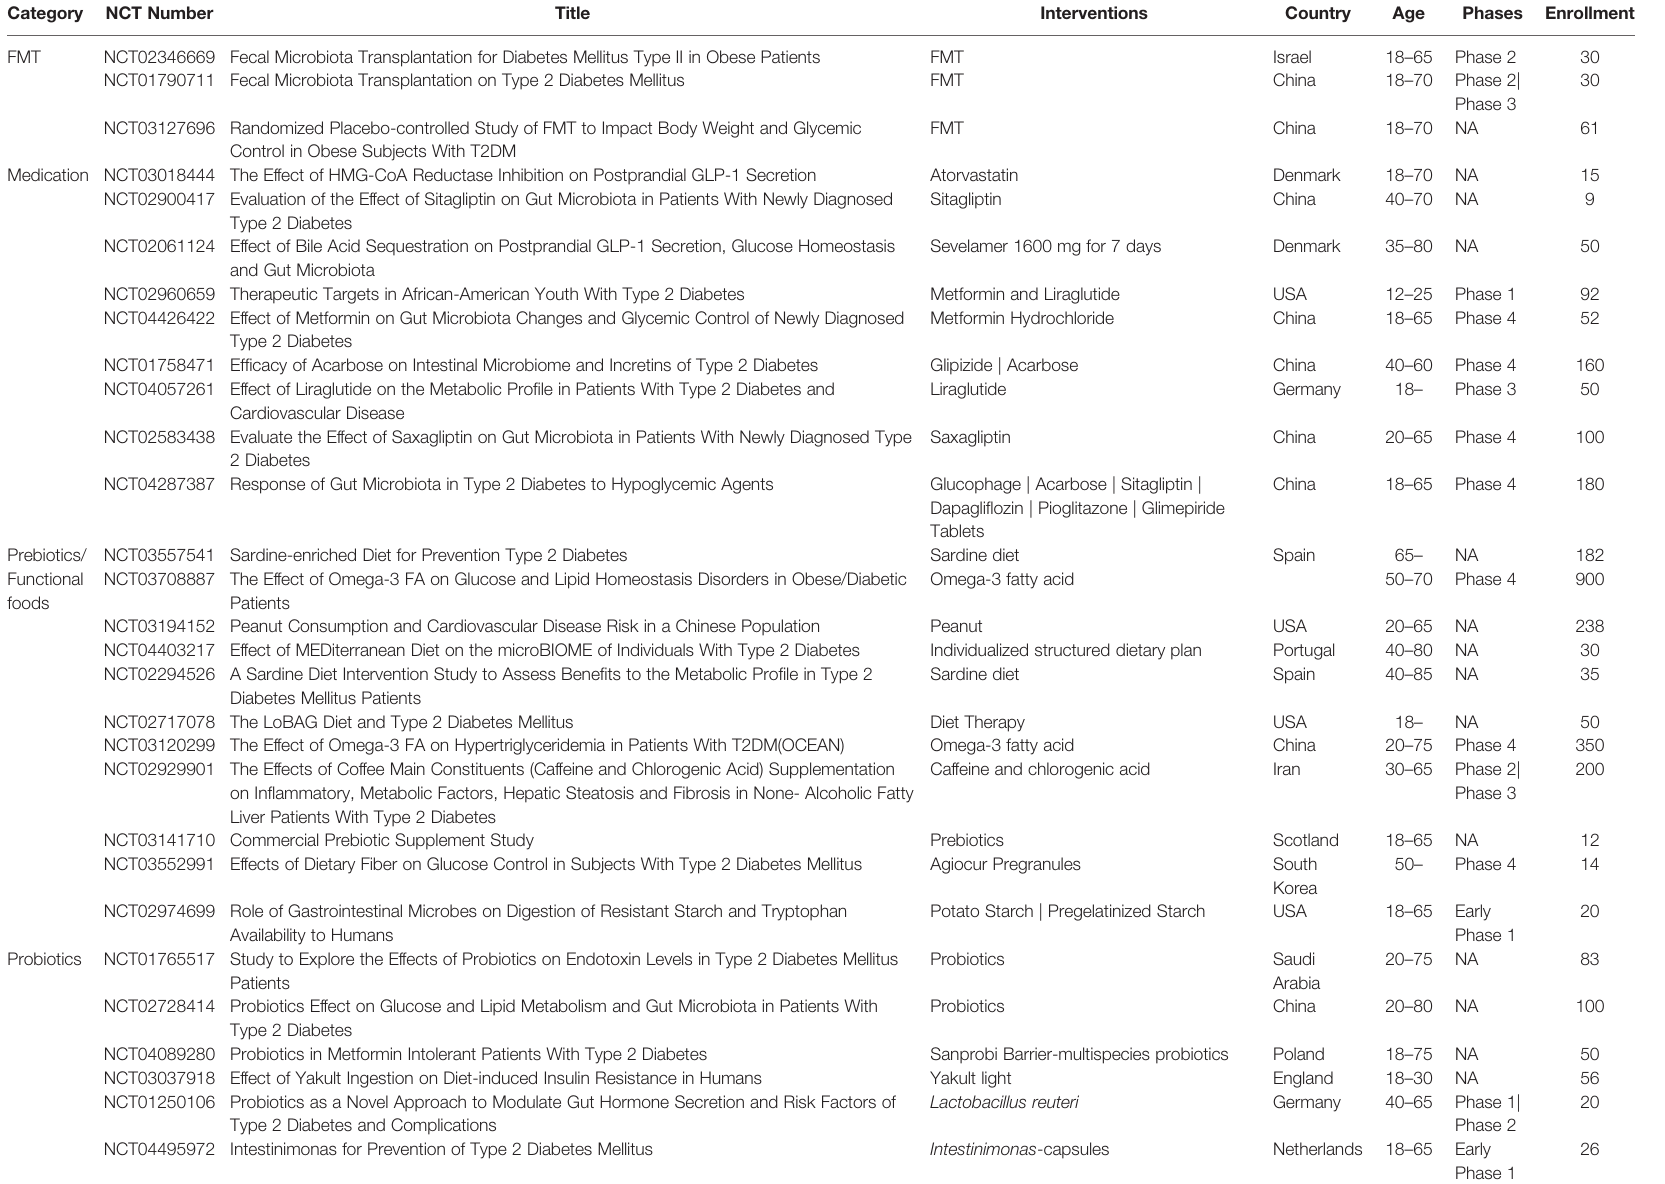
TABLE 3 | Ongoing or completed clinical trials on T2D with FMT, medication, prebiotics/functional foods, or